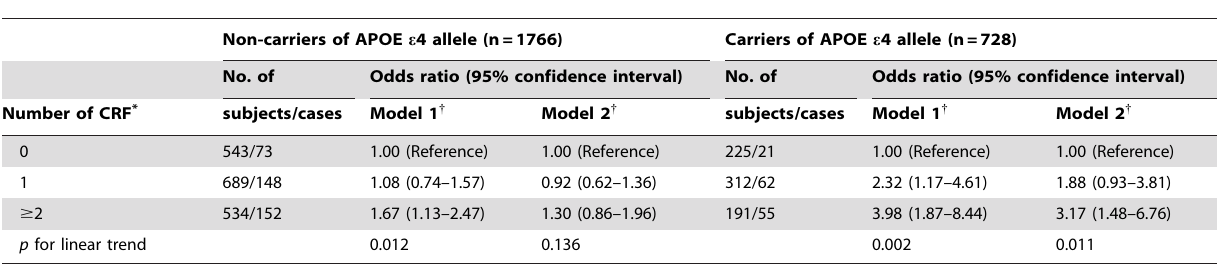
Table 5 . Odds ratios (95% confidence interval) of mobility limitation associated with clustering of CRFs by APOE e 4 status.